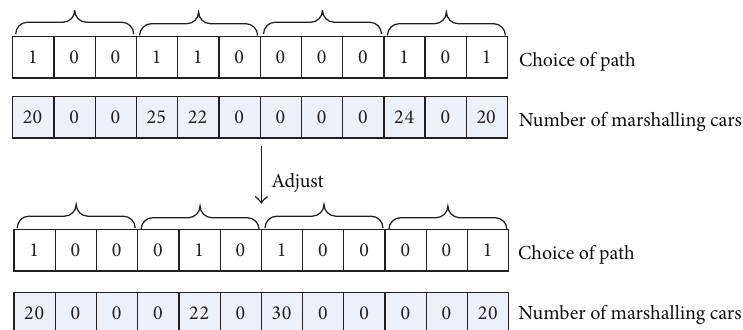
Figure 3: Adjustment of unfeasible chromosome.